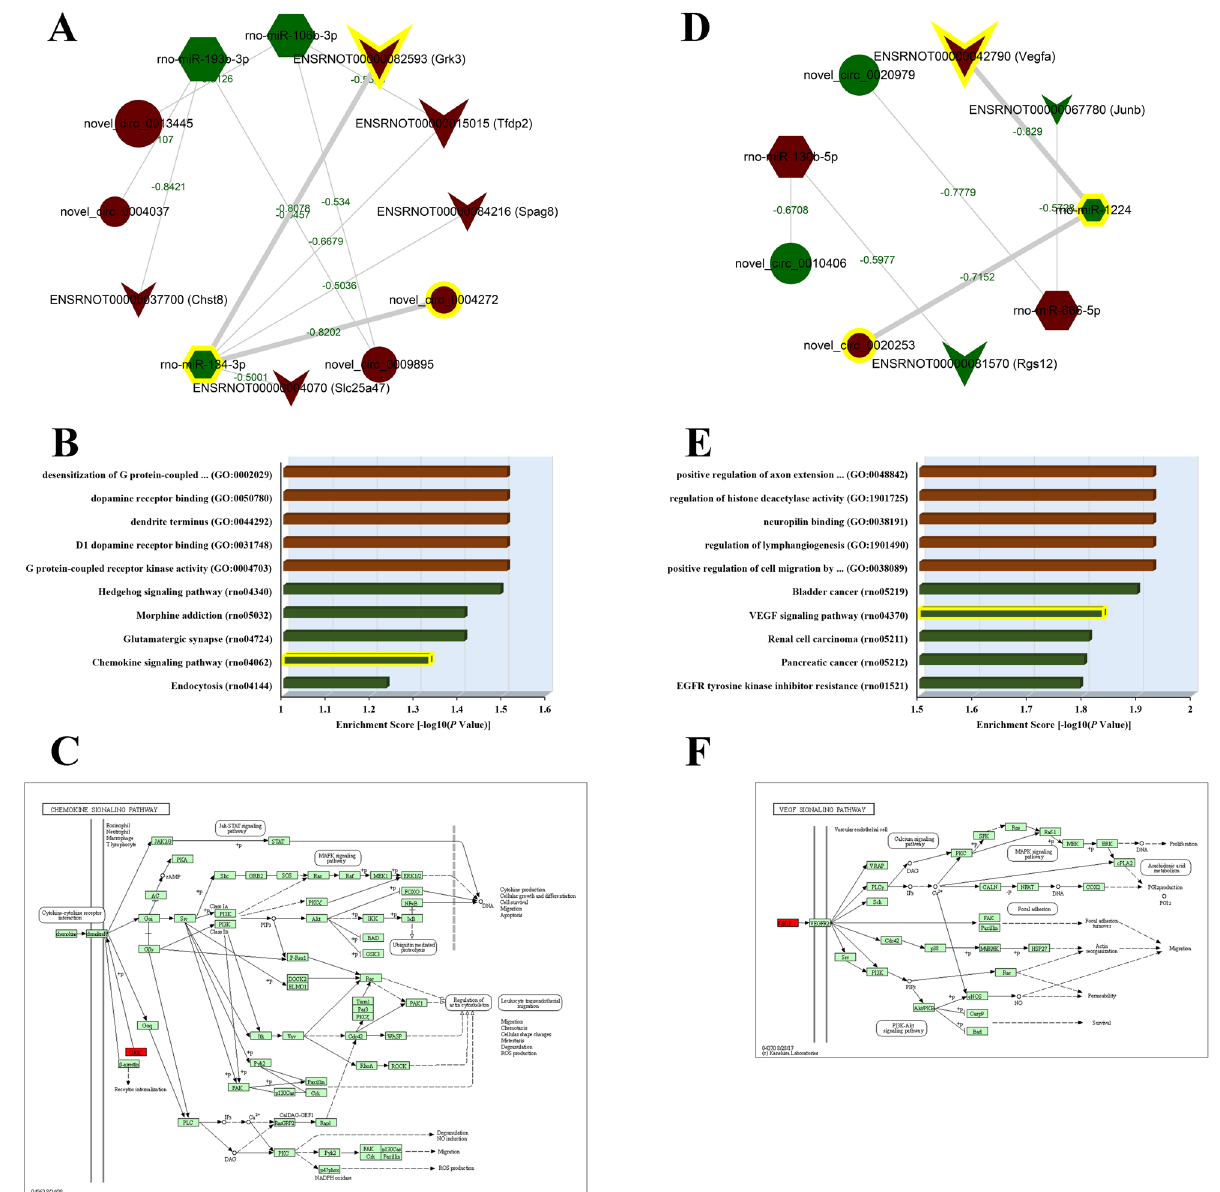
Figure 8. Analysis of hub ceRNA regulatory networks. (A) The 8 pairs of ceRNA networks constructed with 12 hub nodes on the 7th day. Ellipse, hexagon, and V-shape nodes represented circRNA, miRNA and mRNA, respectively. The node size represented the corrected P value (larger nodes for more significant P values). Green and red colors represented down ‐ and up ‐ regulation, respectively. The green values on edges represented the negative Pearson correlation coefficients. The most qualified sub-network of novel_circ_0004272/rno-miR- 134-3p/ENSRNOT00000082593(Grk3) was highlighted by yellow. ( B ) The top 5 most significantly enriched GO and KEGG terms of Grk3. Red bars represented the 5 GO terms; green bars represented the 5 KEGG terms. The enrichment score (-log 10 scale of corrected P value) expressed the regulational extent of the predicted functions by Grk3 in ICH rats compared with Sham. The most qualified KEGG term of Chemokine signaling pathway was highlighted by yellow. ( C ) Detail of Chemokine signaling pathway (https:// www. kegg. jp/ kegg- bin/ show_ pathw ay? map04 062). The target gene was highlighted by red. ( D ) The 3 pairs of ceRNA networks constructed with 9 hub nodes on the 28th day. The most qualified sub-network of novel_circ_0020253/rno-miR-1224/ ENSRNOT00000042790(Vegfa) was highlighted by yellow. ( E ) The top 5 most significantly enriched GO and KEGG terms of Vegfa. The most qualified KEGG term of VEGF signaling pathway was highlighted by yellow. ( F ) Detail of VEGF signaling pathway (https:// www. kegg. jp/ kegg- bin/ show_ pathw ay? map04 370). The target gene was highlighted by